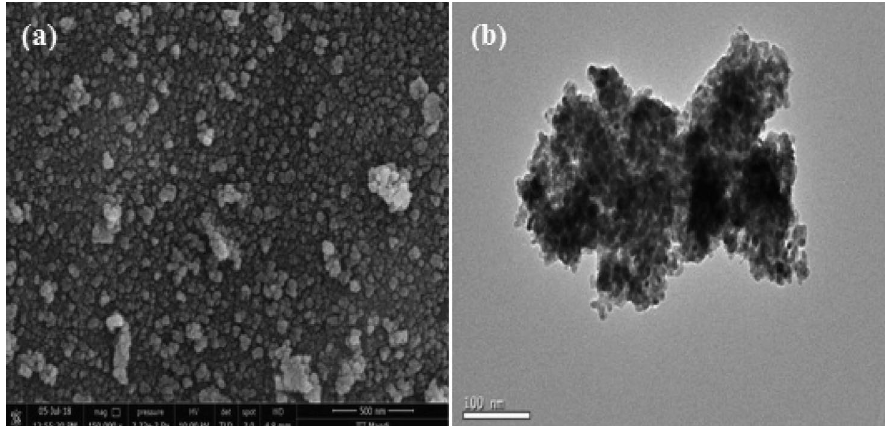
Figure 7. (a) SEM and (b) TEM images of Yb(OH)CO 3 :Tb 3+ precursor